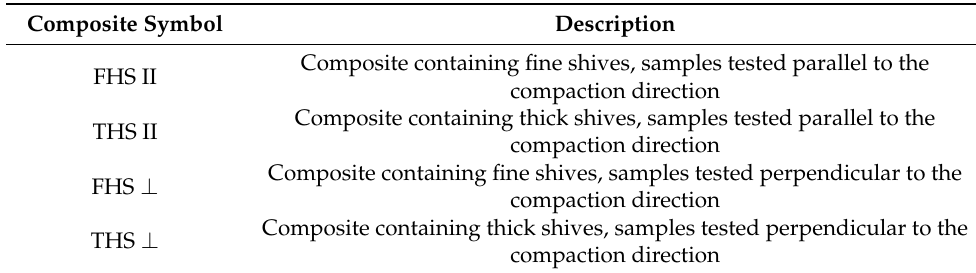
Table 2. Parameters of the analyzed